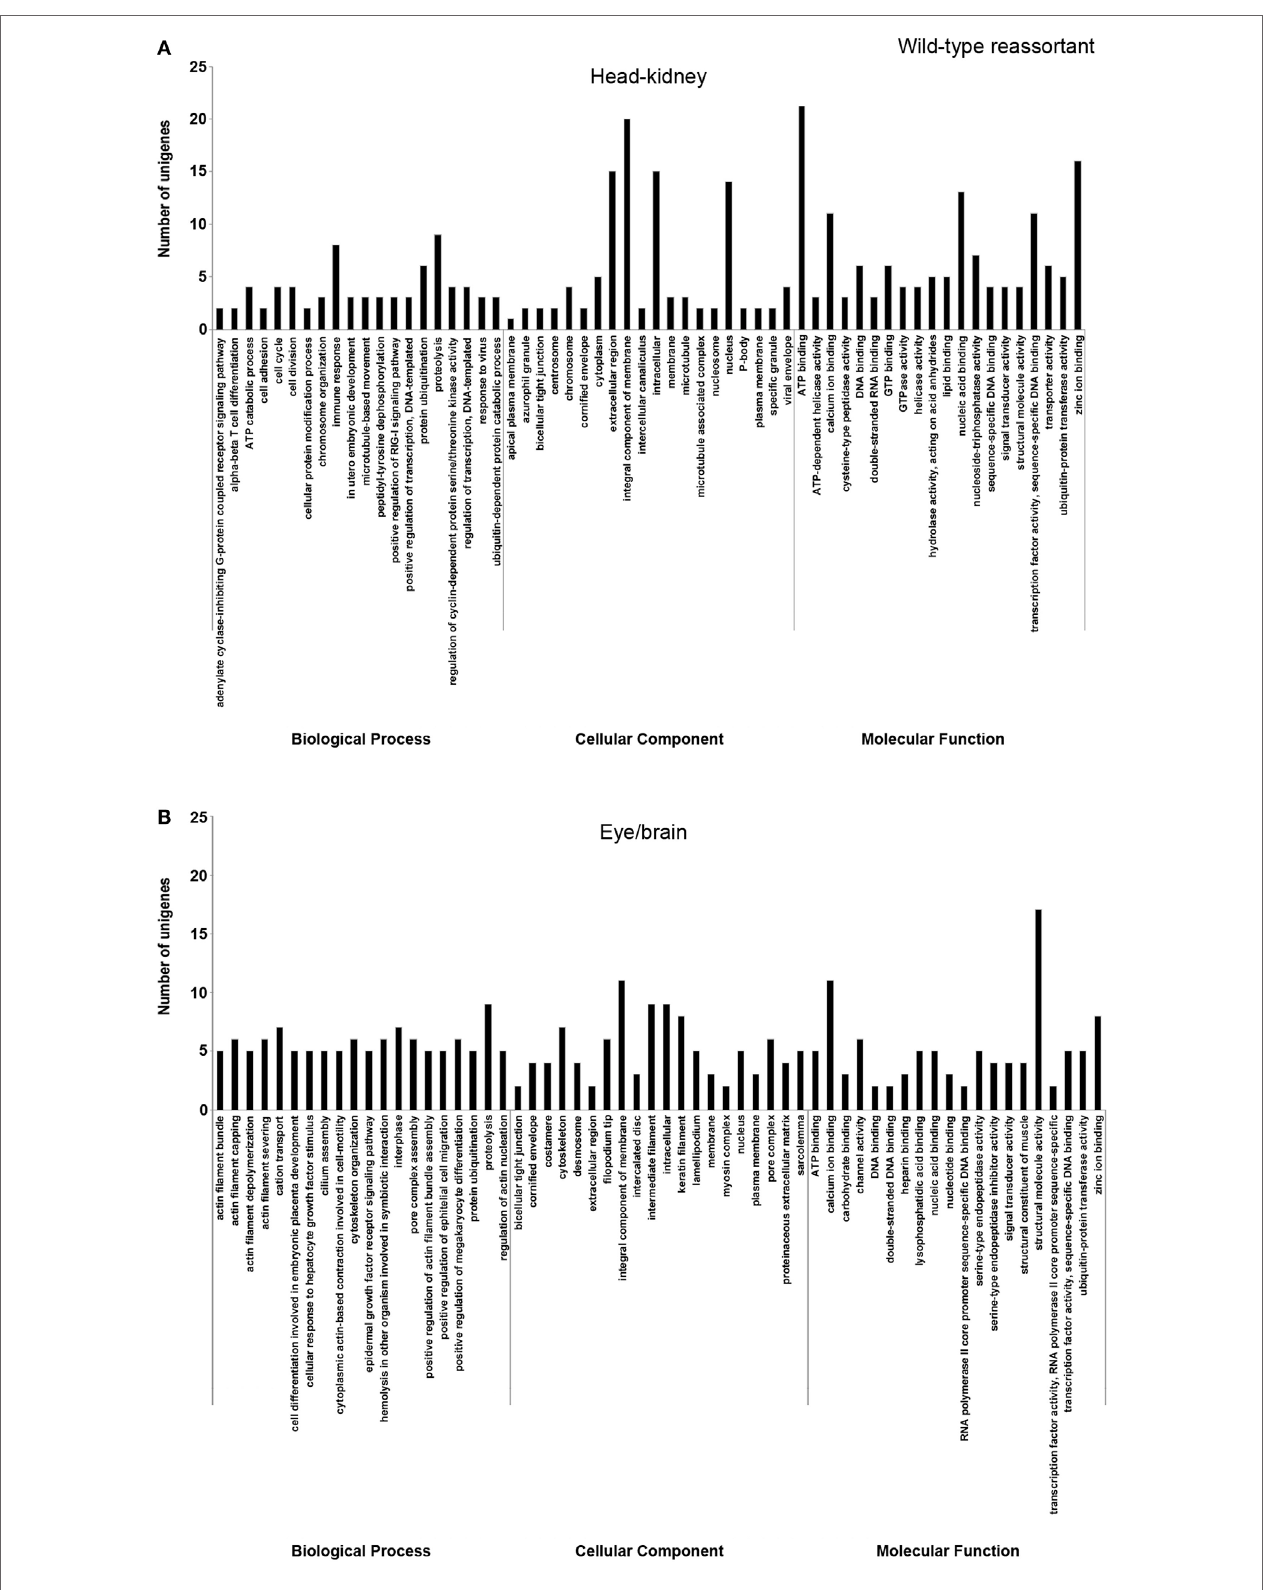
FigUre 2 | Gene ontology enrichment analysis of differentially expressed genes from head kidney (a) and eye/brain (b) samples of Senegalese sole animals infected with the wild-type reassortant. Ontologies were classified into three subclasses, including biological process, cellular component, and molecular